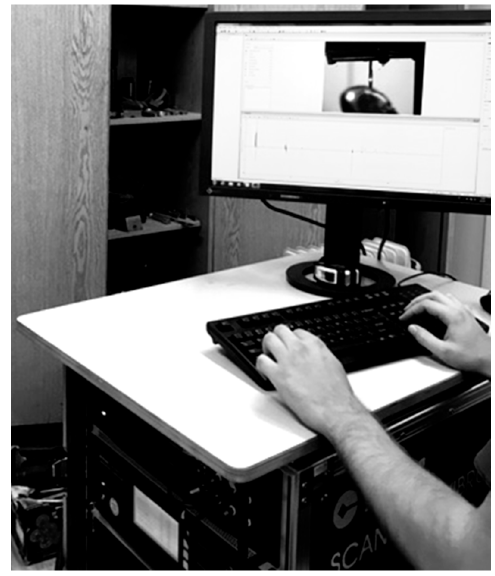
Figure 4. The fixation of the vibration signals.